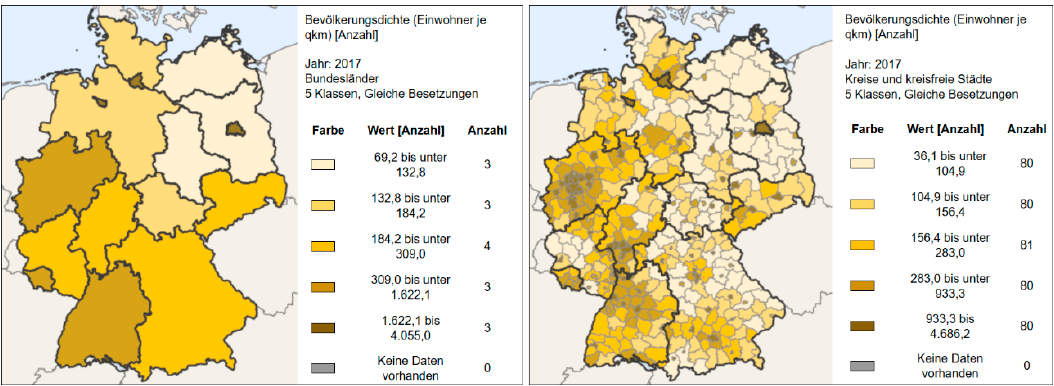
Figure 9. Thematic map of population density (people per km 2 ) 2017 in Germany based on states ( left ) and counties ( right ) [28] (Data licence Germany – destatis – Version 2.0) (Legend shows color, value ranges and number of cases per class).